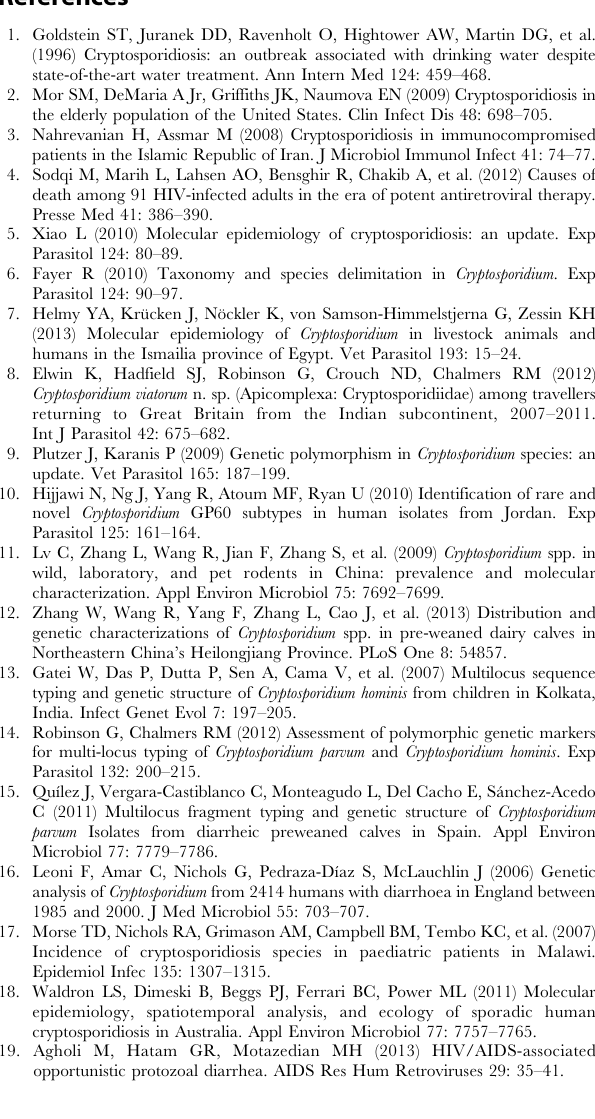
Figure S1 Linkage disequilibrium among different populations by DnaSP analysis of concatenated sequenc- es from four genetic loci. Sequences from four loci were combined in a single contig and analyzed for linkage disequilib-